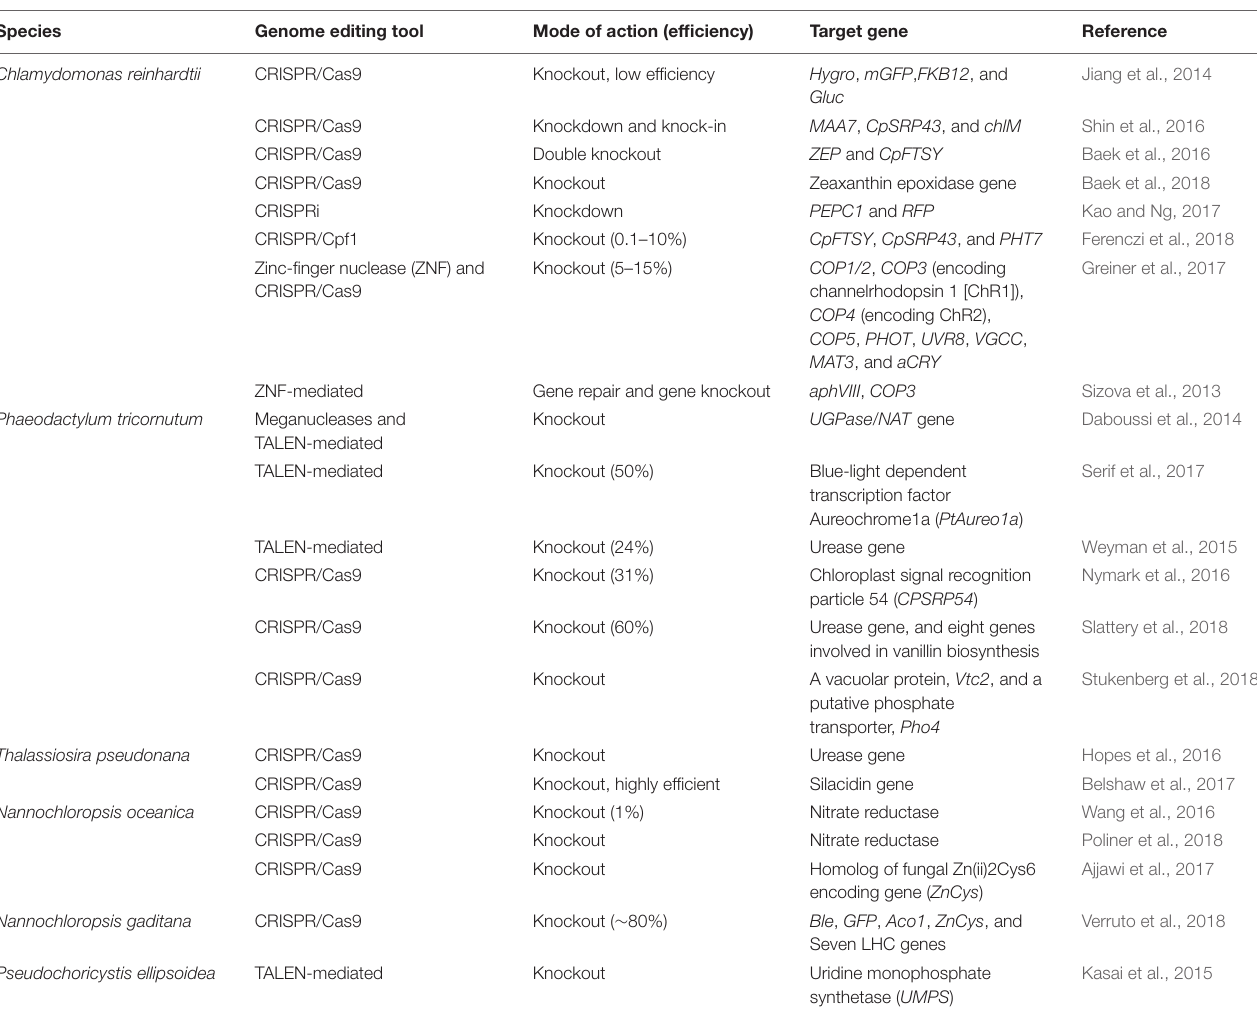
TABLE 3 | Overview of the application of different genome editing tools in photosynthetic microalgae.